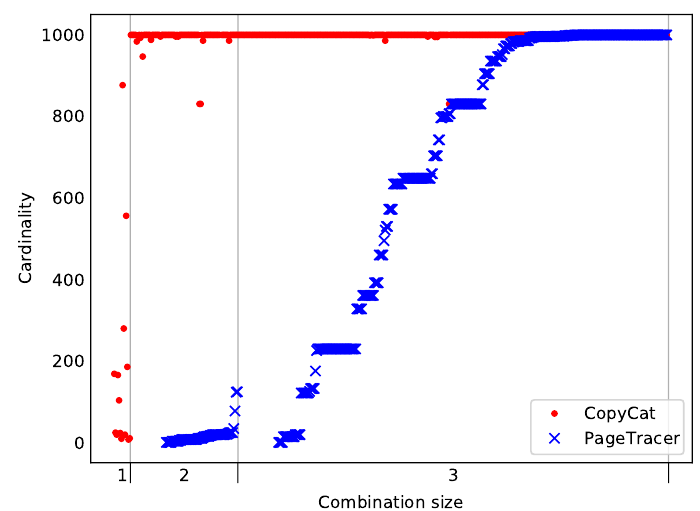
Figure 4: mbedTLS cardinality vs. combination size (partial).